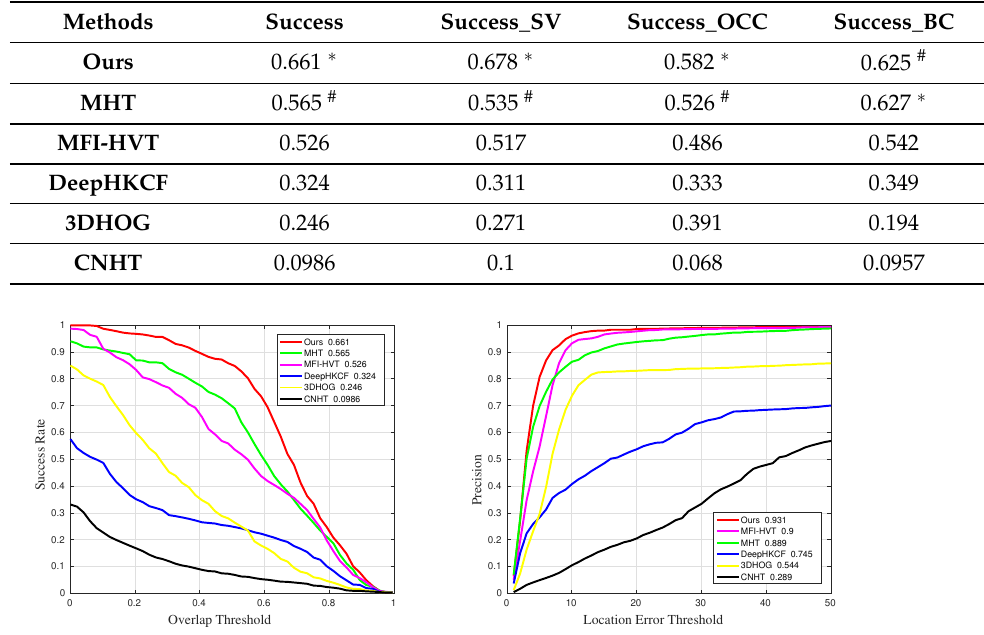
Table 3. The details of success rate results. The suffixes mean that the measurements are only counted in the sequences with the corresponding challenges. The best and the second best results are marked by symbols * and #, respectively.